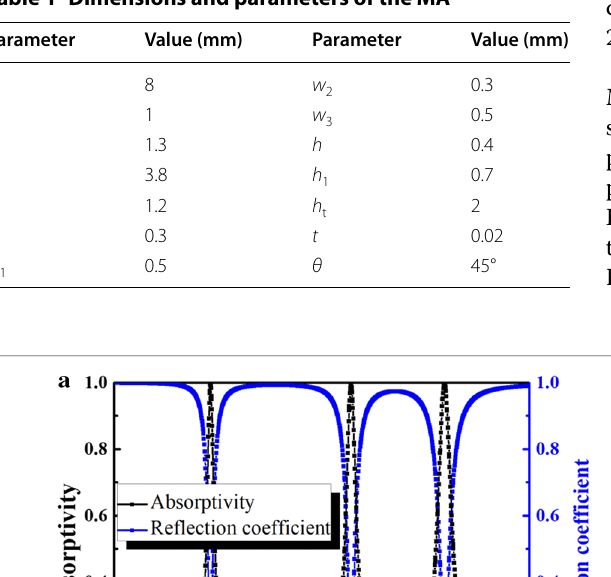
0.02. The optimized parameters of the MA are listed in The simulated absorption spectra of the proposed MA were determined from a finite-difference time-domain (FDTD) simulation. In the simulation, the unit cell boundary conditions were applied in the x and y direc- tions, while the Floquet port condition was imposed along the z direction. Moreover, a plane EM wave was